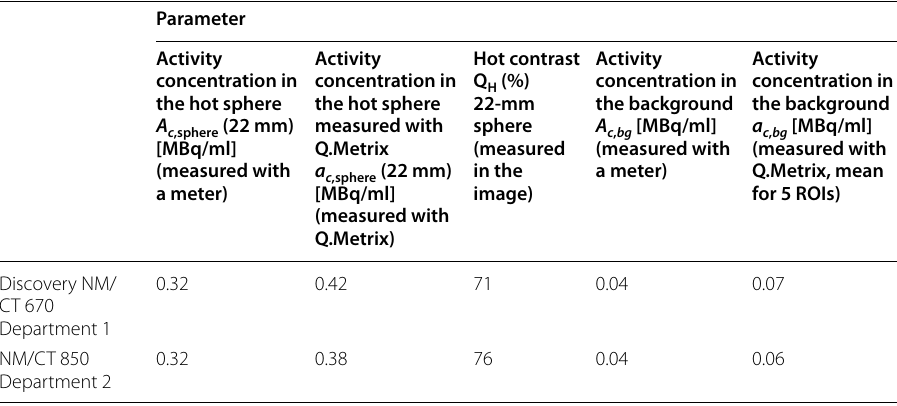
Table 2 Parameters of image quality obtained for the 22‑mm‑diameter sphere and the background of the NEMA/IEC NU2 Body Phantom with two gamma cameras, Discovery NM/CT 670 and